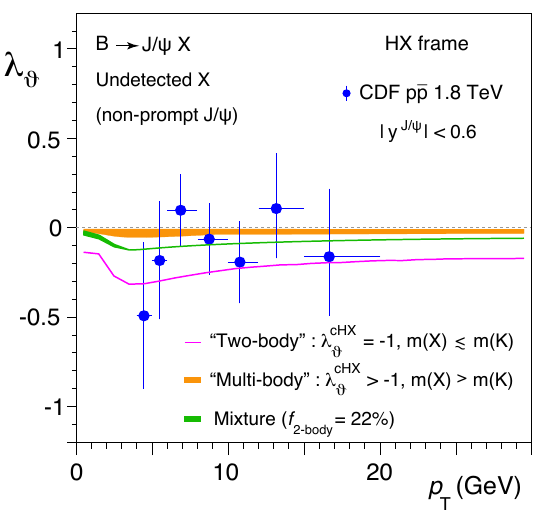
Figure 12 . The non-prompt J /ψ polarization ( λ ϑ in the HX frame) measured by CDF [32] in √ pp collisions at s = 1 . 8 TeV, as a function of p T , in the rapidity range | y | < 0 . 6 , compared to predictions assuming that the J /ψ is produced in two-body (pink curve) or multi-body (orange band) B decays, the width of the band reflecting reasonable variations of the λ cHX and h m X i parameters. ϑ The green band represents a mixture of these two kinds of processes, as motivated in the text. The simulation used the B p T distribution measured by CDF (figure